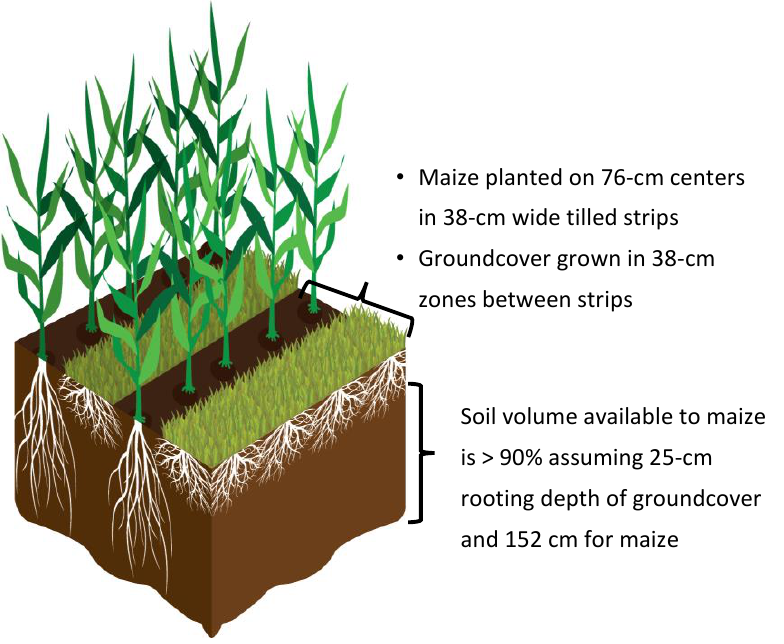
Figure 6. Profile of established maize growing with perennial groundcover. In this configuration, maize is planted into 38-cm tilled strips alternating with 38-cm wide strips of perennial groundcover. Base groundcover is 50% providing resistance to surface water flow, increased infiltration, and decreased soil erosion. Belowground, the groundcover occupies less than 10% of the soil volume reserving over 90% for the grain crop to exploit. Management practices should be designed to maintain localization of the two species in time as well as space to ensure minimum competition and optimum grain production. The ideotype for a perennial groundcover is cool-season growth (spring and fall), summer dormancy, a shallow root system, rhizomatous or stoloniferous regrowth, shade tolerance, and winter hardiness.